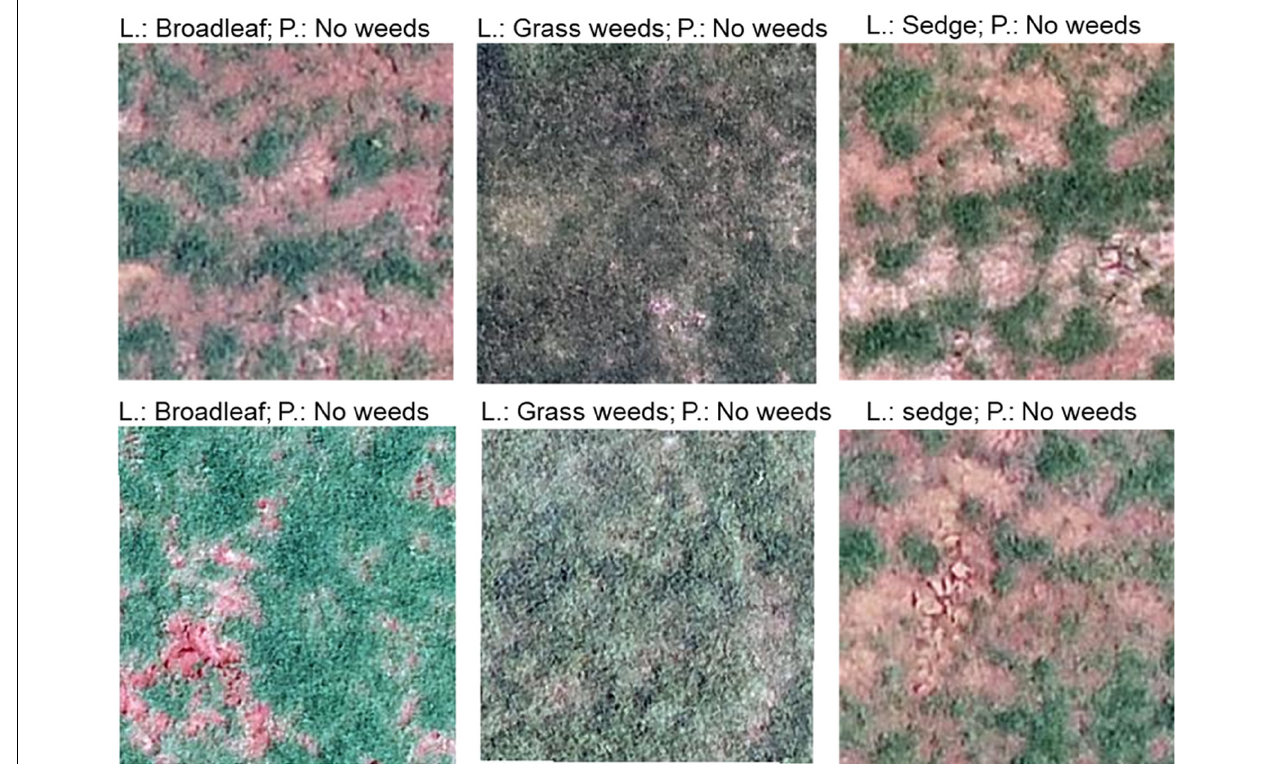
FIGURE 6 | Examples of misclassified images by the convolutional neural network (CNN). L, true label; P, prediction.